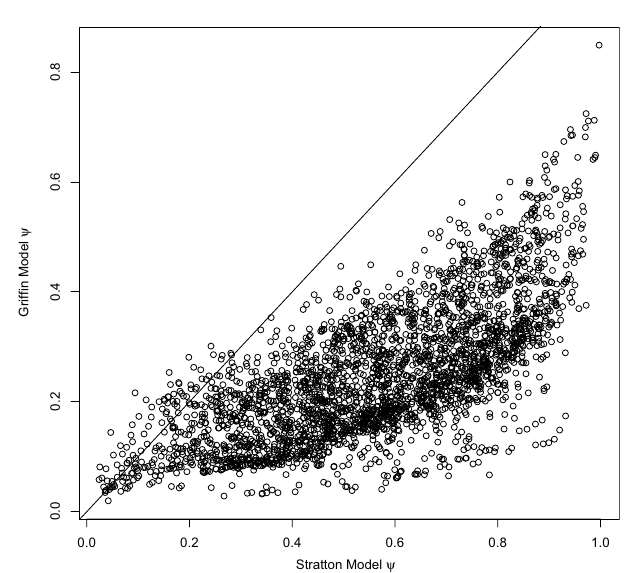
Figure 6. Paired site posterior mean occupancy probabilities for the Stratton et al . 18 model (x-axis) and Griffin et al . 16 model (y-axis), the black line represents the line through the